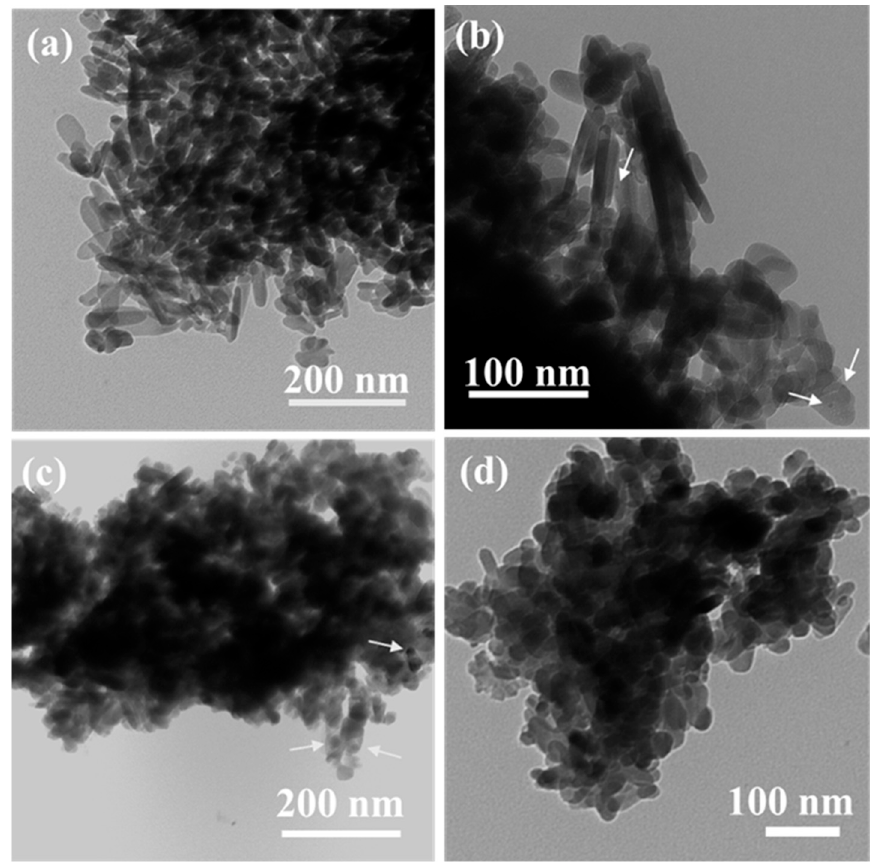
Figure 7. TEM images of ( a ) HAp, ( b ) 5 CuHAp ( c ) 20 CuHAp and ( d ) Spent 5Cu/HAp catalysts .